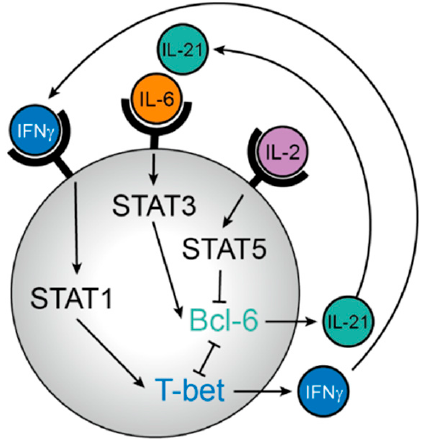
Figure 1. Regulation of T follicular helper (Tfh) versus T helper-1 (Th1) differentiation by cytokine signals. Induction of the Tfh cell master transcription factor Bcl-6 critically relies on binding of the transcription factor STAT3 (induced via interleukin- (IL-) 6 and IL-21) to its promoter and is inhibited by STAT5 (induced via IL-2). STAT5 does not only inhibit STAT3 binding to the Bcl6 locus, but additionally induces the transcription factor Blimp-1, a direct antagonist of Bcl-6, thus promoting the development of non-Tfh effector T cells such as Th1 cells. As an additional feed-forward loop, the Th1 master transcription factor T-bet forms a repressive complex with Bcl-6 and inhibits a number of genes important for further Tfh cell development.